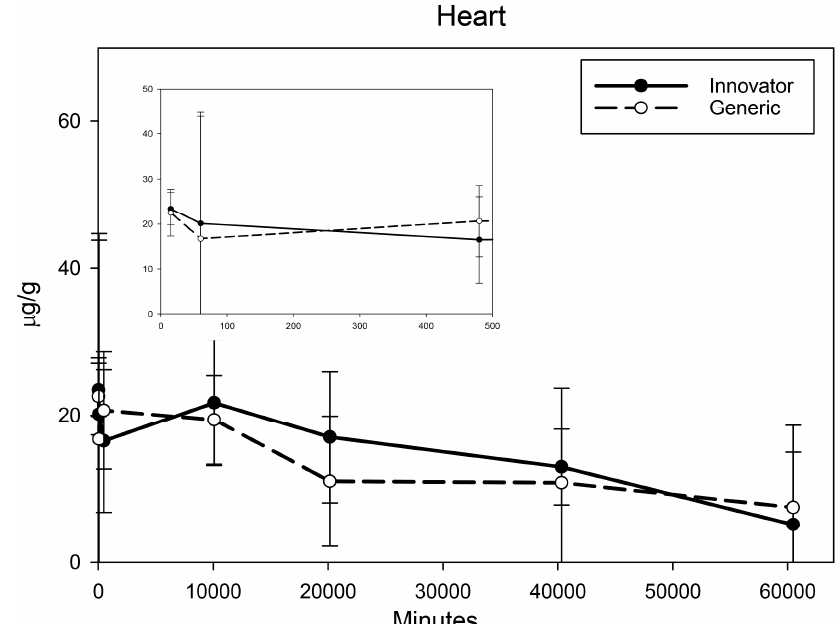
Figure 4. Heart mean iron concentrations over time. Endogenous (control) iron concentration was subtracted from both the innovator (solid) and the generic (dashed). Negative results are not graphed. Time points = 15 min, 60 min (1 h), 480 min (8 h), 10,080 min (1 week), 20,160 min (2 weeks), 40,320 min (4 weeks), 60,480 min (6 weeks). Inset shows the first three time points (15 min, 1 h, 8 h). Values are shown as mean + SD; n = 6 per group per time point.